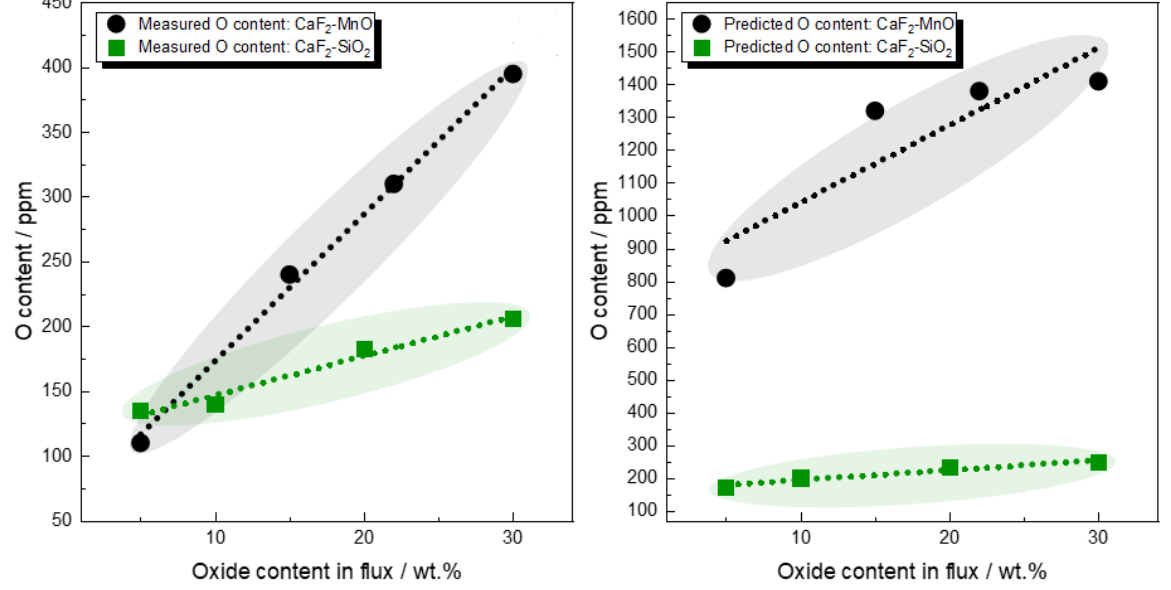
Figure 10. WM O content as a function of oxide content in flux.